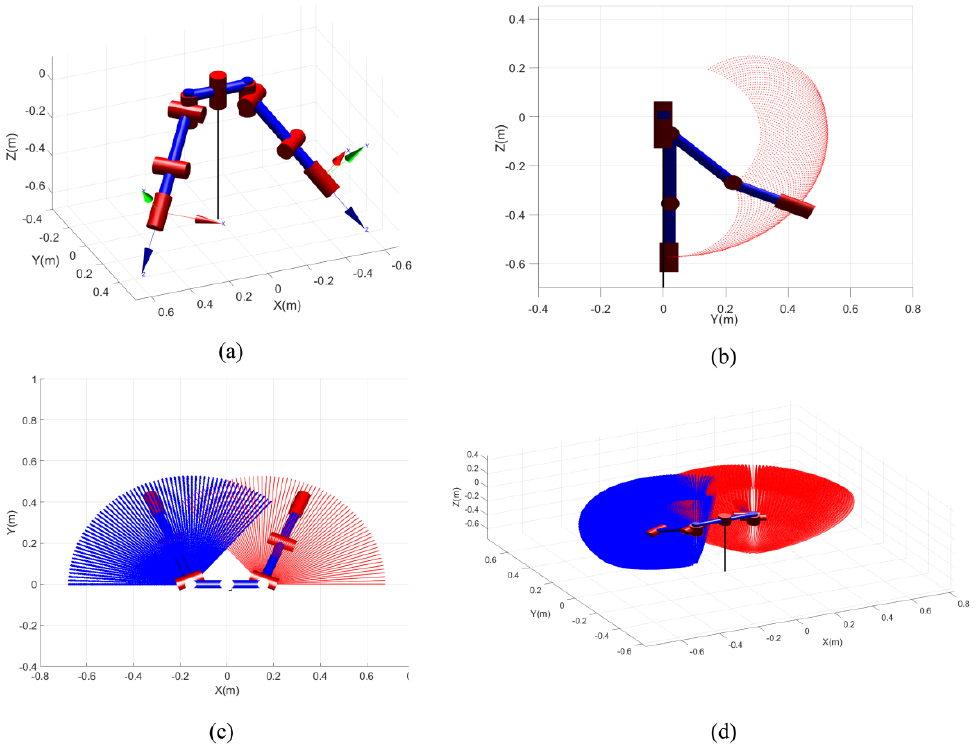
Figure 3. ( a ) Simulation model of workspace analysis; ( b ) Workspace projection on YZ plane; ( c ) Workspace projection on XY plane; ( d ) Schematic diagram of three dimensional workspace.